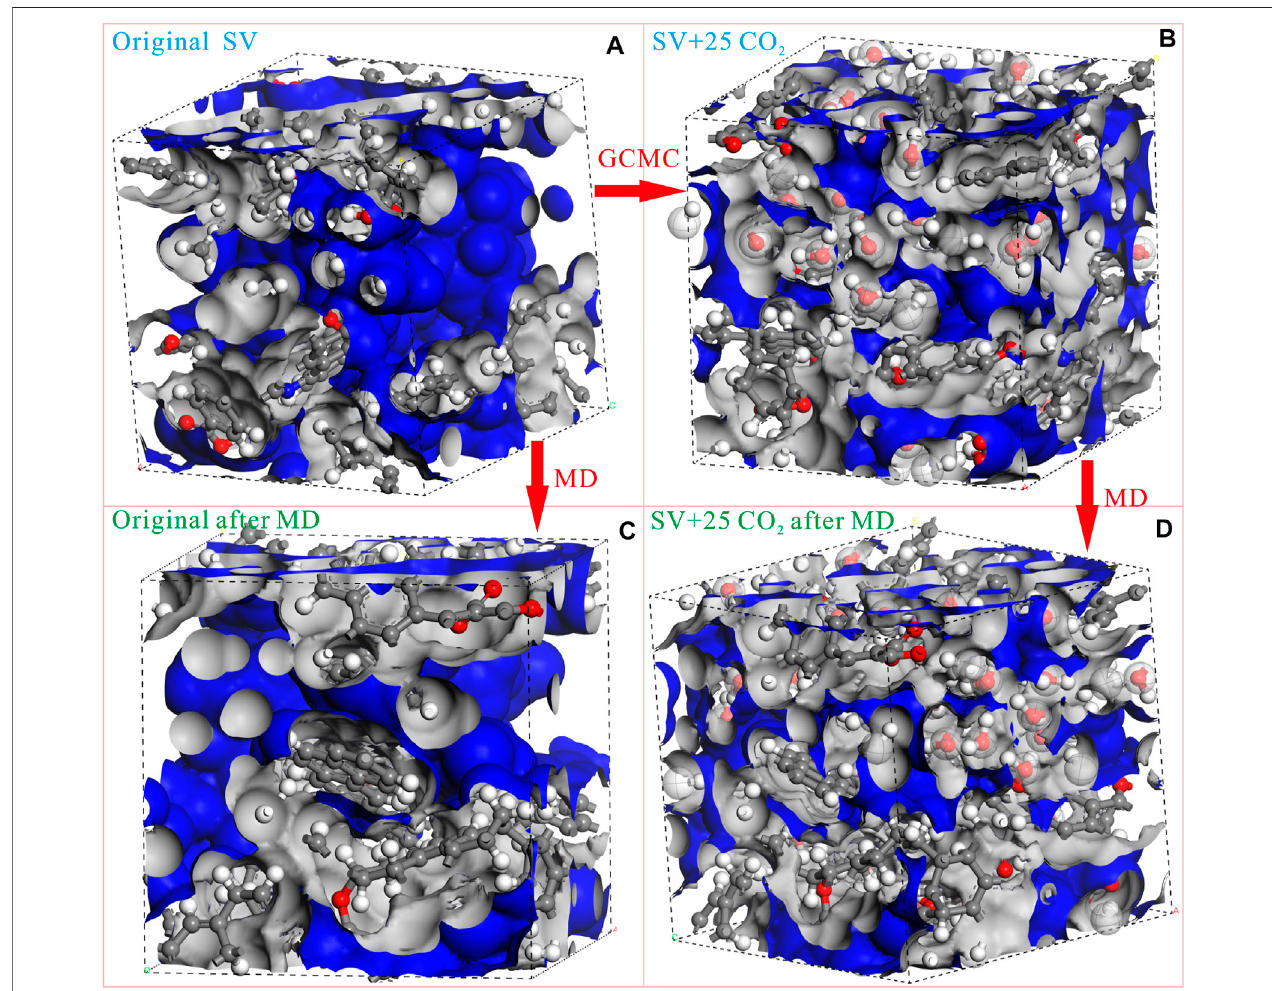
FIGURE8| Thecalculation fl owoftheswellingdeformationforlow-rankcoalvitrinitemacromolecularrepresentation(at273 Kand0.1 MPa;theoccupiedandfree volume are depicted as the gray zone and blue zone, respectively.).